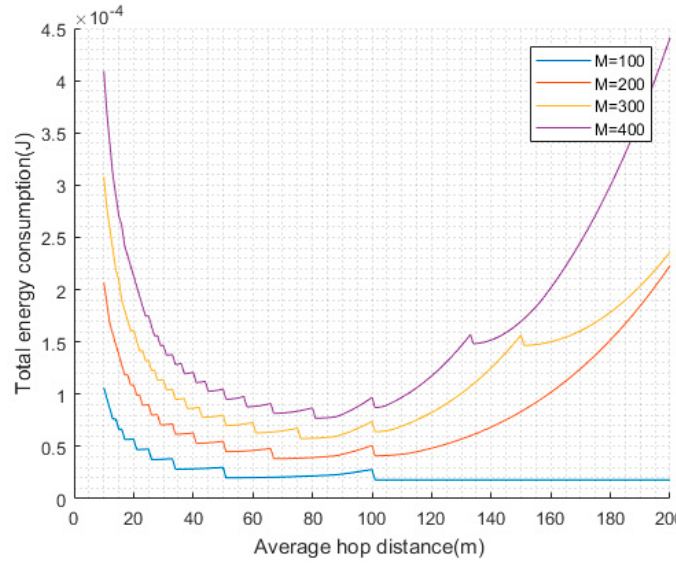
Figure 3. Optimal communication distance.